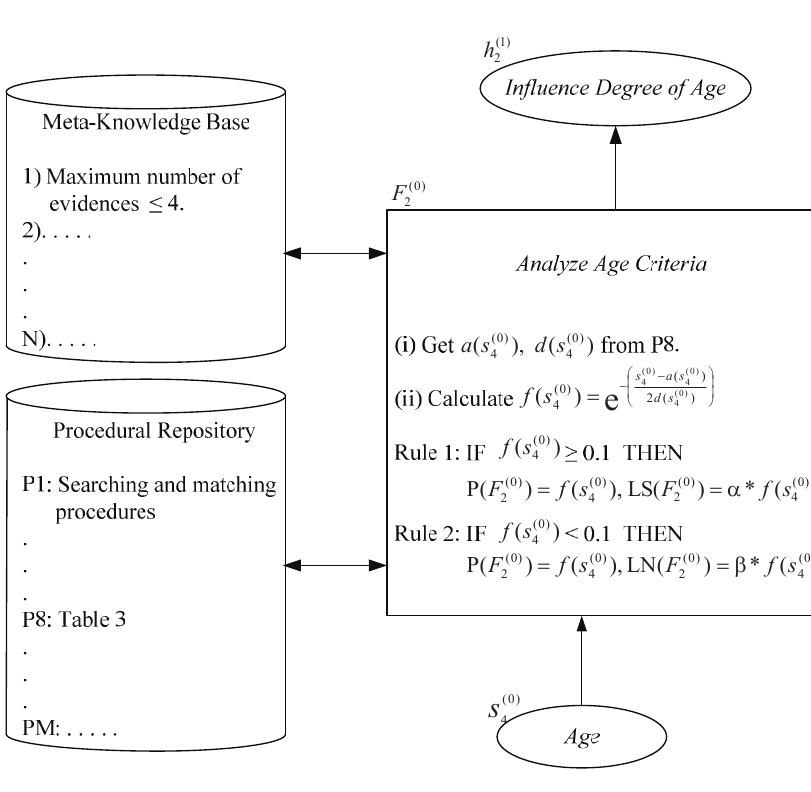
Figure 3. Branch 2 of HBFIN constructed by using GBINM.